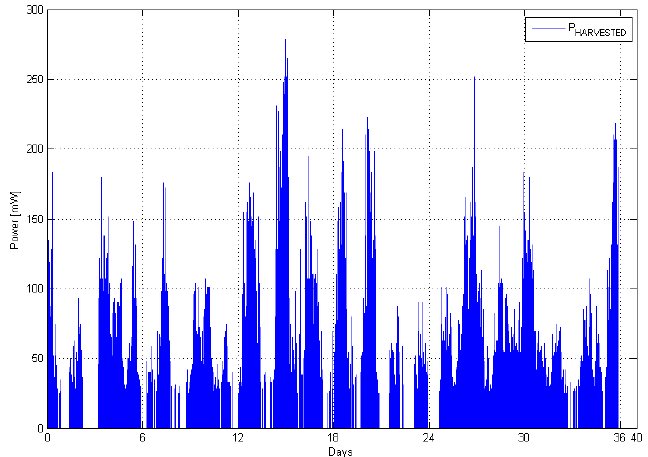
Figure 5. Harvested power from the wind during the 35 days of experiment—deployment (I).